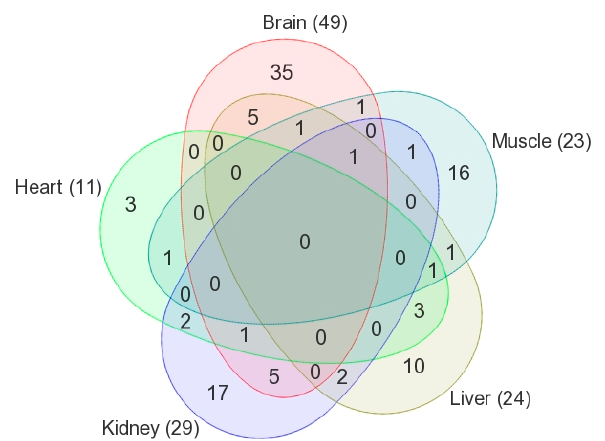
Figure 6. Venn diagram illustrating the number of shared and unique positively identified metabolites that are significantly altered in Dex ‐ treated animals among different tissues (brain, heart, kidney, liver, and muscle).